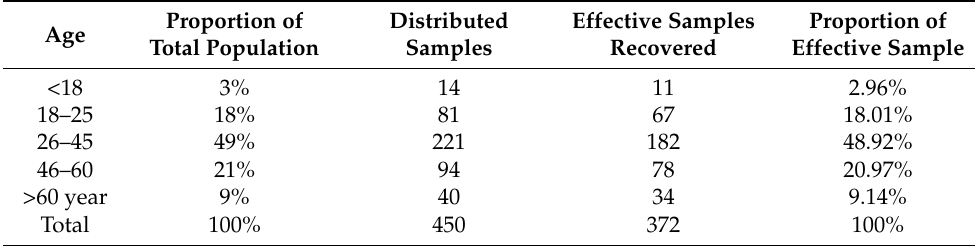
Table 6. Number of questionnaires distributed and